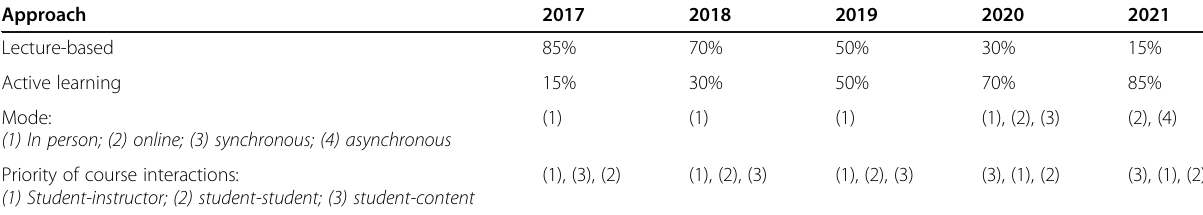
Table 1 Gradual shift in learning approaches